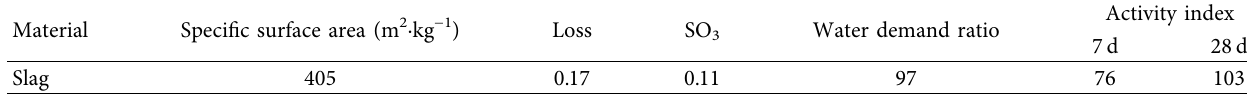
Table 5: Basic physical properties of slag (in percentage).